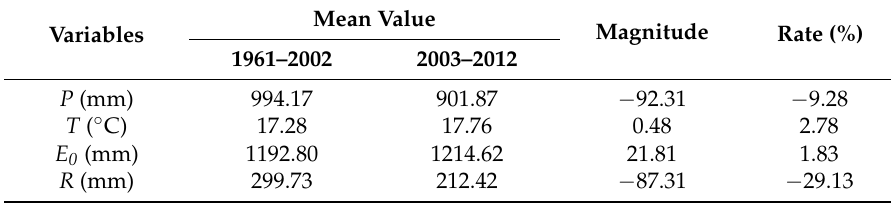
Table 2. Changes in mean annual P , T , E 0 , and R during the two periods.